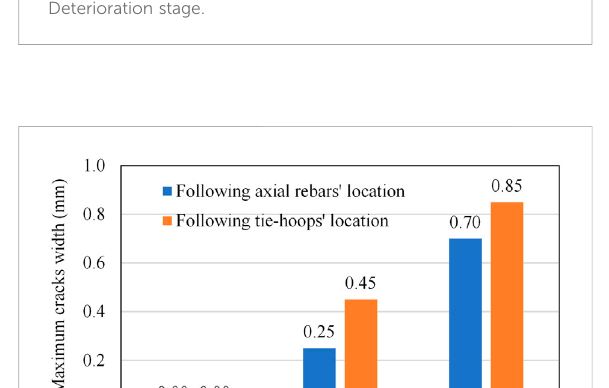
FIGURE 7 AE sensors ’ location (A) schematic of longitudinal view, (B) schematic of transverse view, and (C) during compression test.